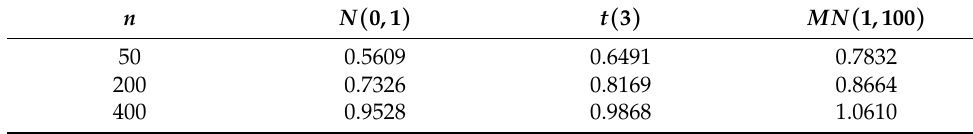
Table 4. CPU times for different n in Example 1.